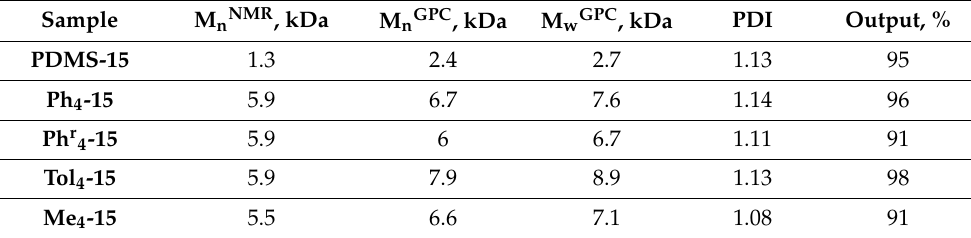
Table 1. Molecular-mass characteristics of a linear arm and star-shaped polymers.